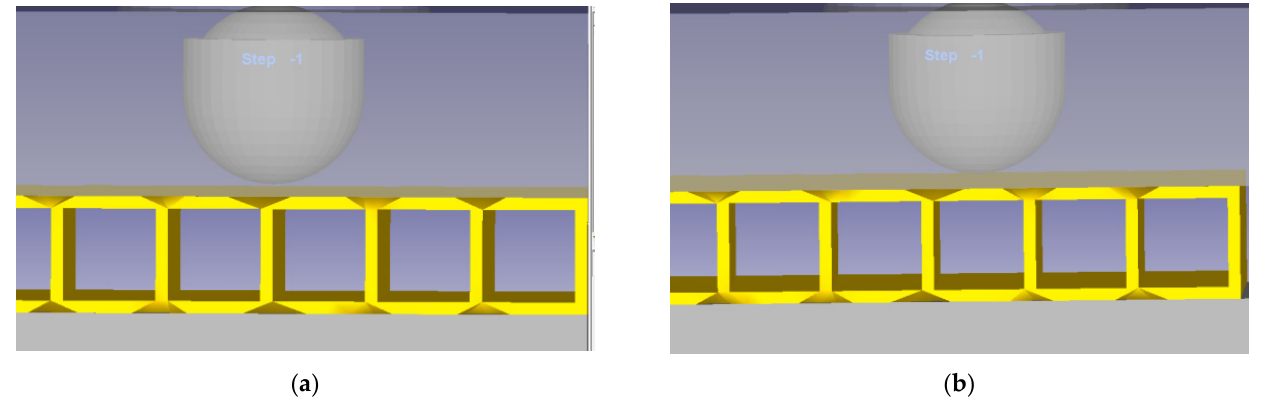
Figure 3. Model of impactor head and composite structure. ( a ) On connection layer. ( b ) Between connection layers.